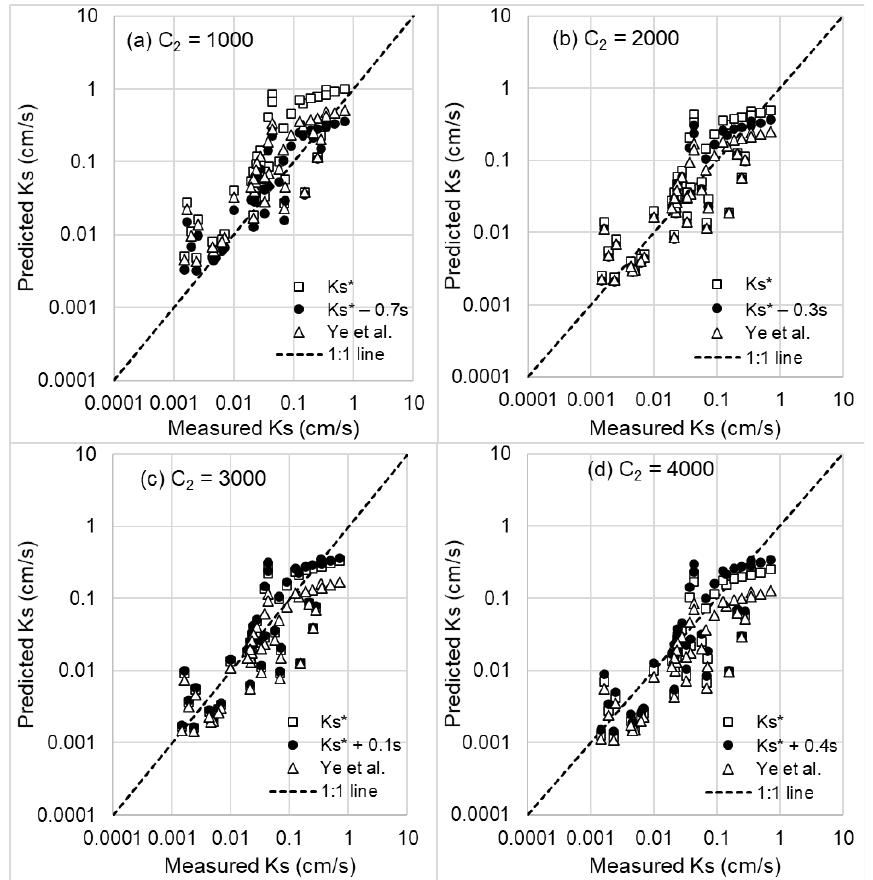
Figure 1. Comparison with experimental saturated hydraulic conductivity Ks data compiled by Ye et al. [12] from 5 different sources (Zhu [52], Cui [53], Ren et al. [54], Huang et al. [55], and Ye et al. [12]) and listed in their Table 2. The range of C 2 presented in ( a – d ) in this figure is the same as that tried in Ye et al. [12].